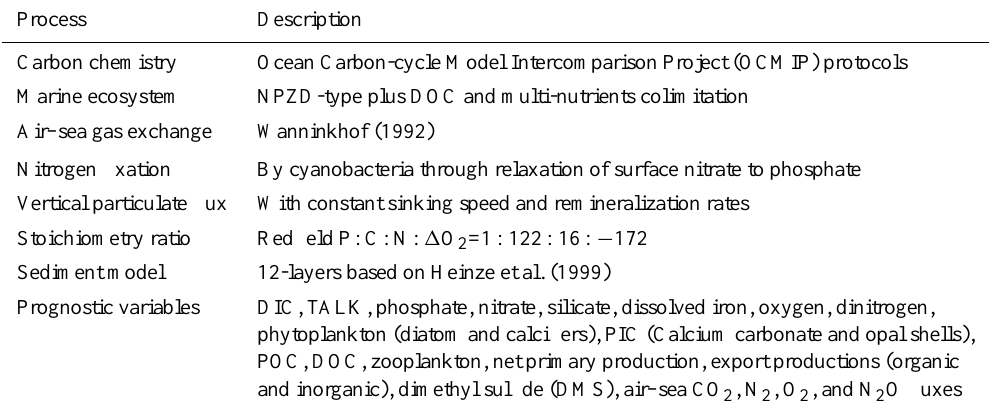
Table 1. Marine biogeochemical processes featured in the HAMOCC5